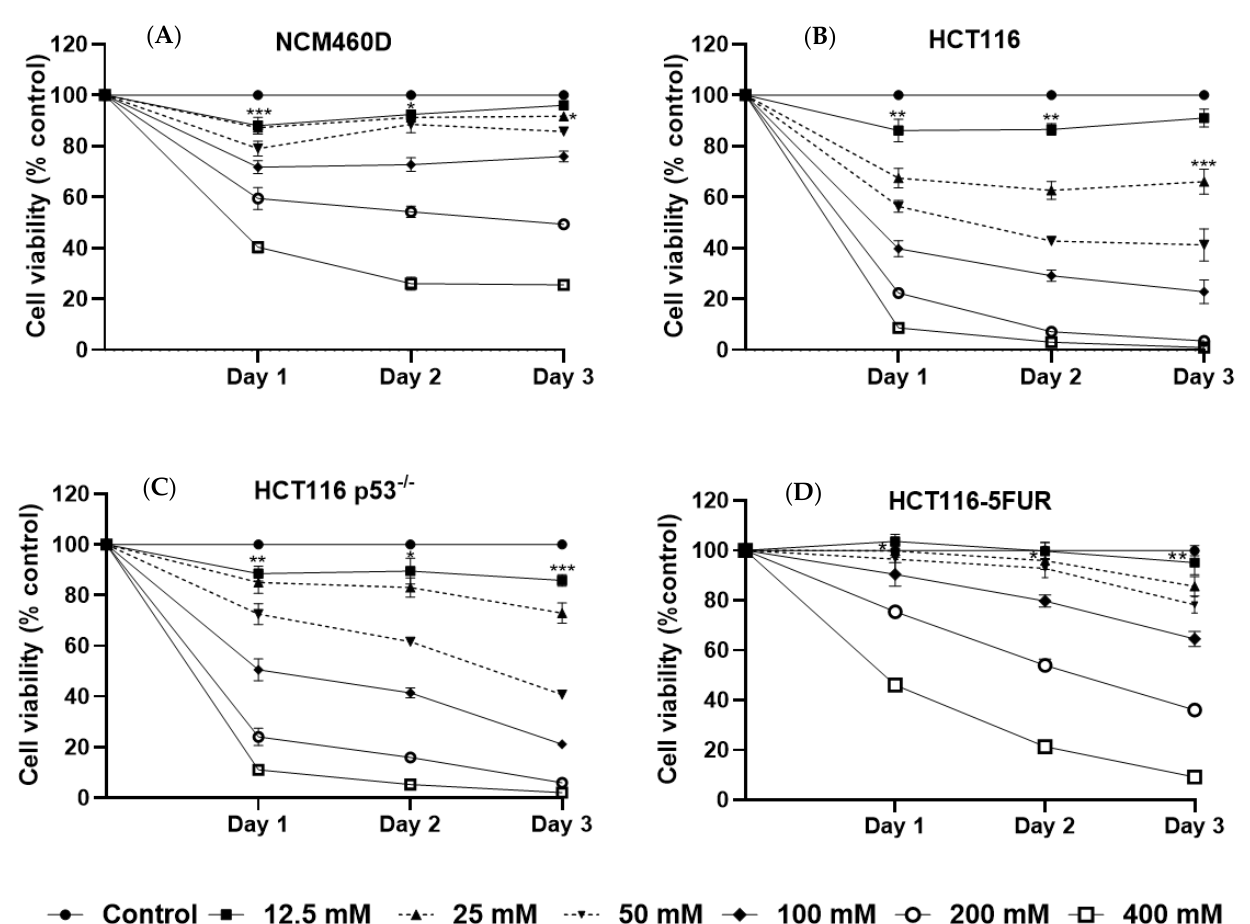
Figure 2. Mannose reduces cancer cell viability. Effect of mannose on ( A ) normal-like colon cells NCM460D, ( B ) HCT116, ( C ) HCT116 p53 − / − , and ( D ) HCT116-5FUR cells. Results are expressed as a percentage of the control and represent the average of at least three independent experiments ± SEM. The asterisk represents the lowest concentration showing a significant decrease in cell viability in treated versus control cells. Significance from the control is indicated by * p < 0.05, ** p < 0.01, and *** p < 0.001.